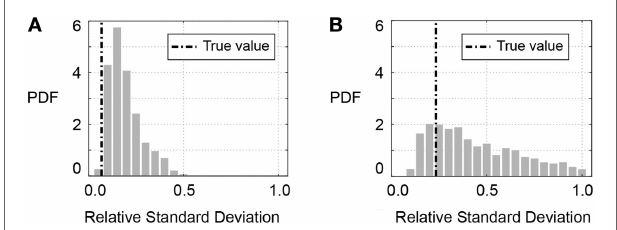
FIGURE 8 | Identification results for parametrized uncertainties in traditional Bayesian model updating application (S 3,TBMU in Table 2 ). The SD of a zero-mean normal distribution is identified. (A) Likelihood function for initial frequency ( f ini ) and (B) likelihood function for post-earthquake frequency ( f peq ).